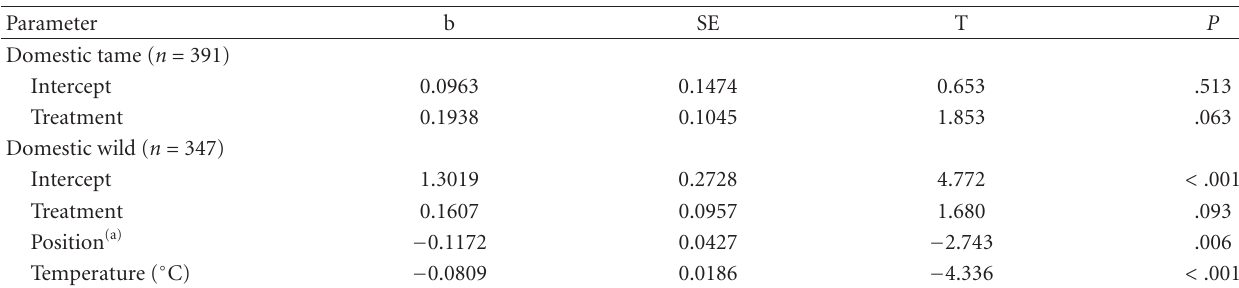
Table 3: Results from the best mixed log-linear model of number of activity changes/minute of two trials with 12 domestic reindeer each. Animals of di ff erent degree of tameness were tested separately. Intercept in all models is the estimate for zone 1 in a control enclosure. The model uses a log-link; so e ff ects must be summed and exponentiated to make predictions.